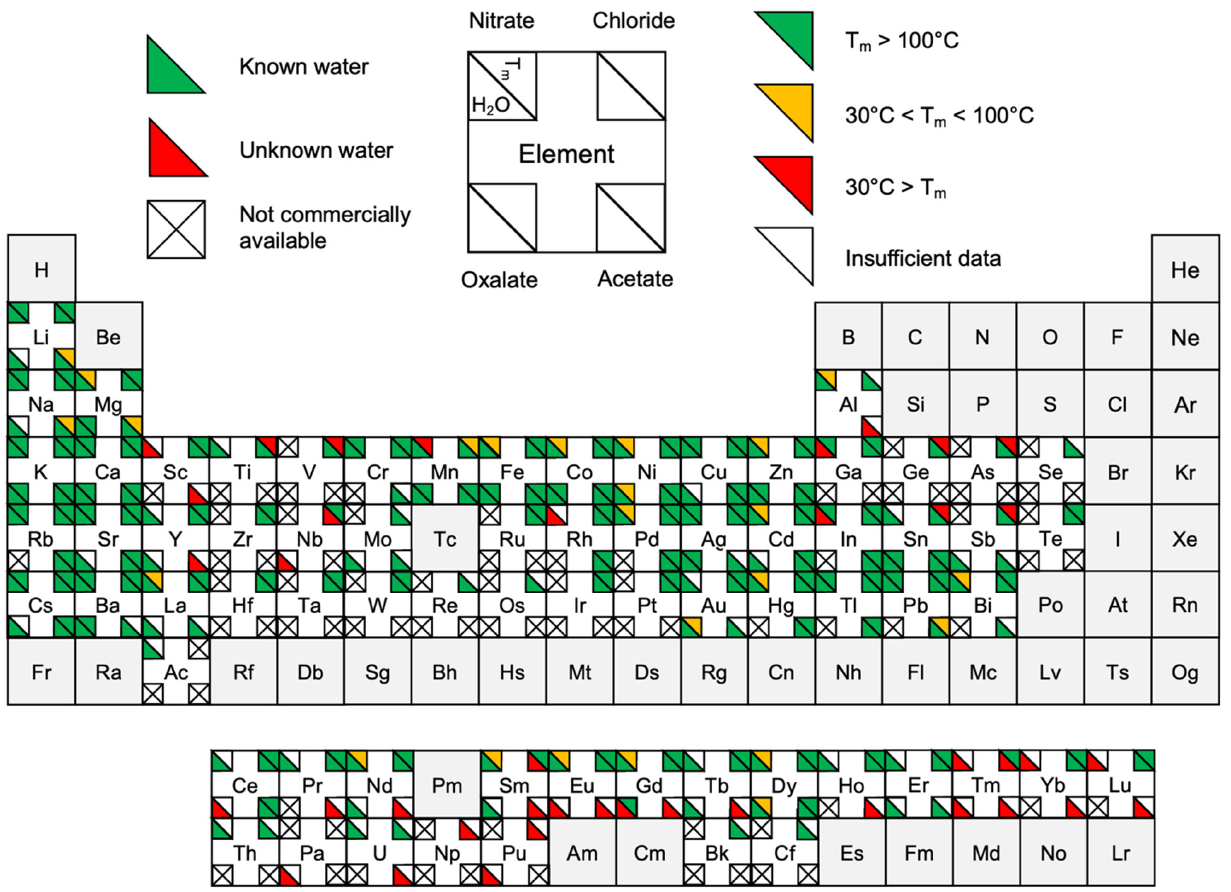
Figure 4. Periodic table of elements detailing the hydration concentration and melting temperature for commercially available precursors. The four corners in each element contain precursor information for nitrates, chlorides, oxalates, and acetates as designated in the key. Grey shaded elements with no information did not show any available commercial precursors for the four types identified. A square with an “x” shows that that specific precursor is not commercially available. The bottom left triangle in a corner informs whether the precursor contains known moles of water in the crystal lattice where green shows that the chemical can be purchased with a known hydration concentration and red shows that the chemical can only be purchased with an unknown hydration concentration. The top right triangle of a corner depicts the range containing the precursor’s melting temperature: green for a melting temperature greater than 100 °C, yellow for between 30 °C and 100 °C, red for below 30 °C, and white for insufficient data to determine the melting temperature.